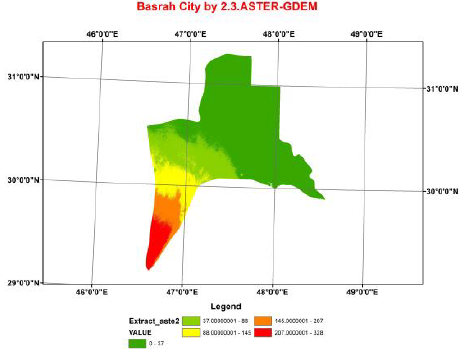
Figure 3. ASTER elevation model.